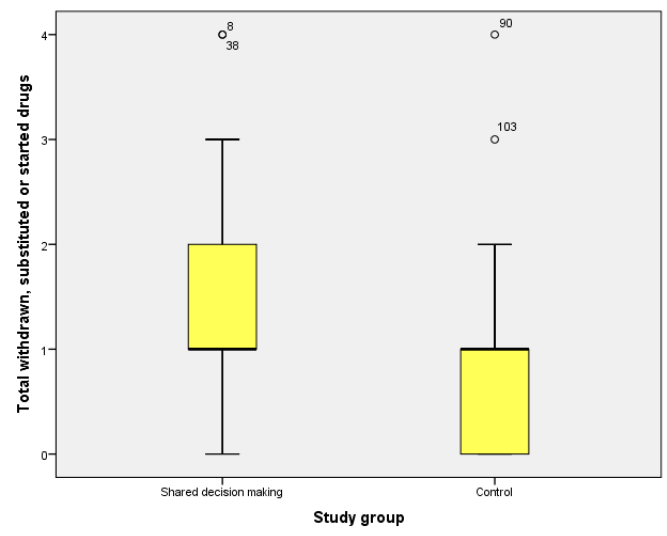
Figure 2. Drugs withdrawn or started, by groups.